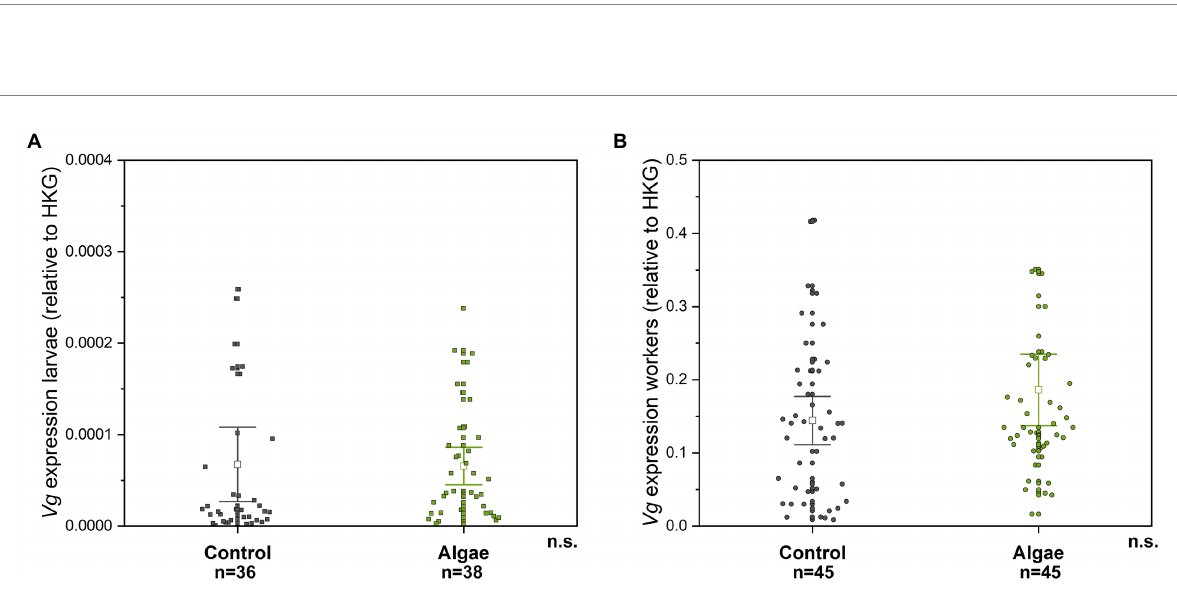
FIGURE 2 The relative gene expression of Vg in bee larvae (A) and adult bees (B) . n.s. – non-significant difference. Control – bees from colonies fed with APIVITAL® sugar syrup. Algae – bees from colonies fed with 10% (w/v) Chlorella powder in APIVITAL® sugar